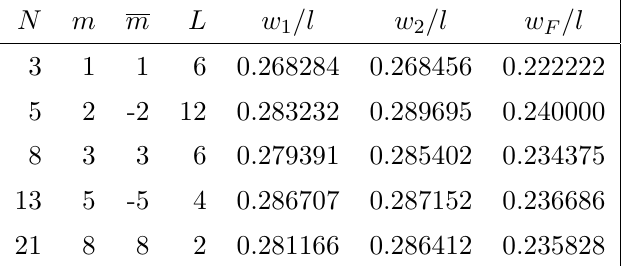
), given by eq. (3.27) with m = 2 and l F